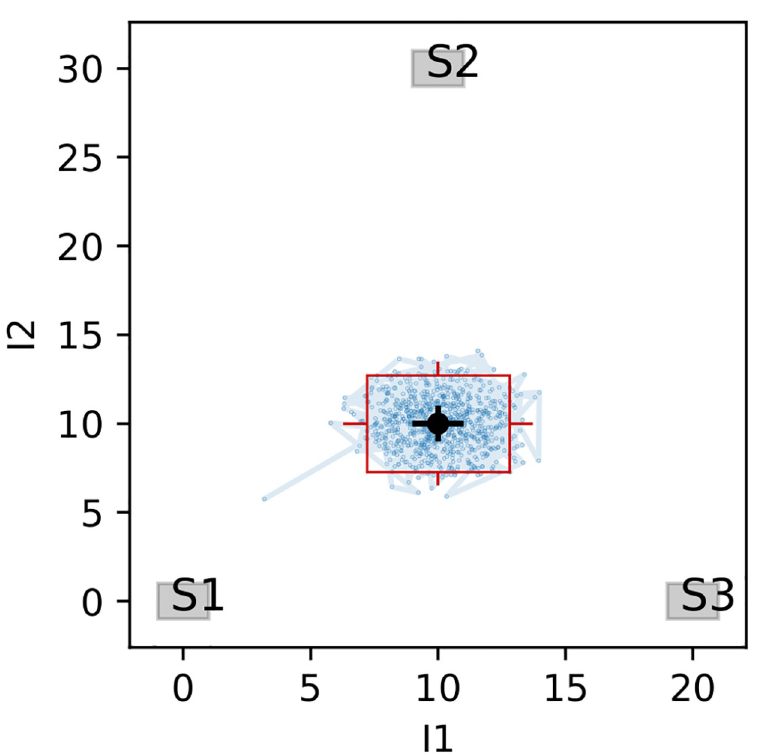
Fig 4. The path of consecutive entries stored in the Markov chain plotted in I 1 , I 2 plane. Each dot represents a model value μ calculated for each of mixing configurations ( f 1 , f 2 , f 3 ) and the line connects consecutive entries. The measurement is denoted with a black dot and error bars, while the sources and their spread are represented with shaded rectangles. The red rectangle represents the boundary with the middle at x and sides’ length is taken as Δ Eq 15). Additional red whiskers stand for σ i (see Eqs 13 and